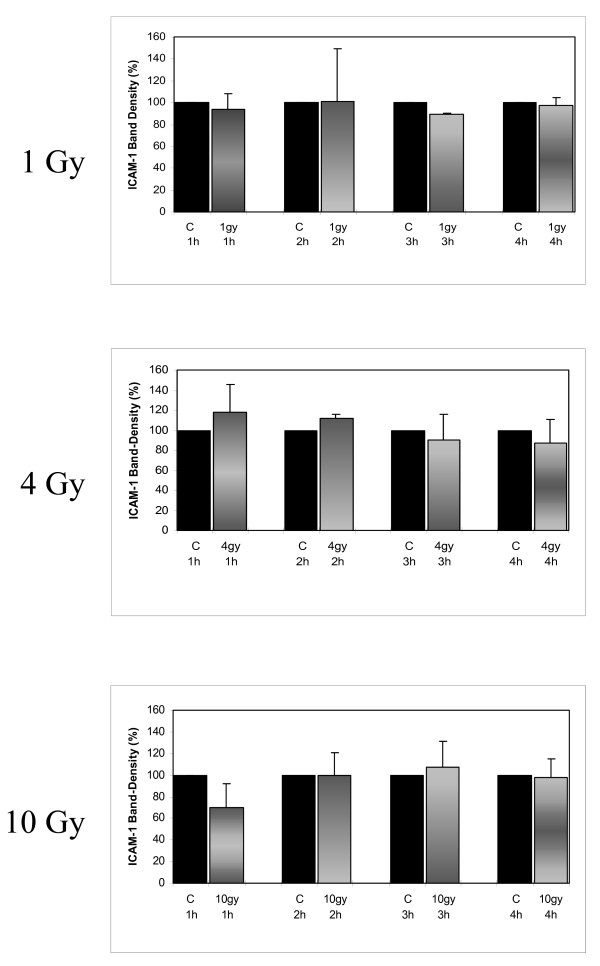
Relative band density of Northern blots of ICAM-1 expression 1 h, 2 h, 3 h, and 4 h after low dose irradiation of human MC with doses of 1 Gy, 4 Gy, and 10 Gy. Expression of ICAM-1 in quiescent MC was not affected by low dose irradiation.